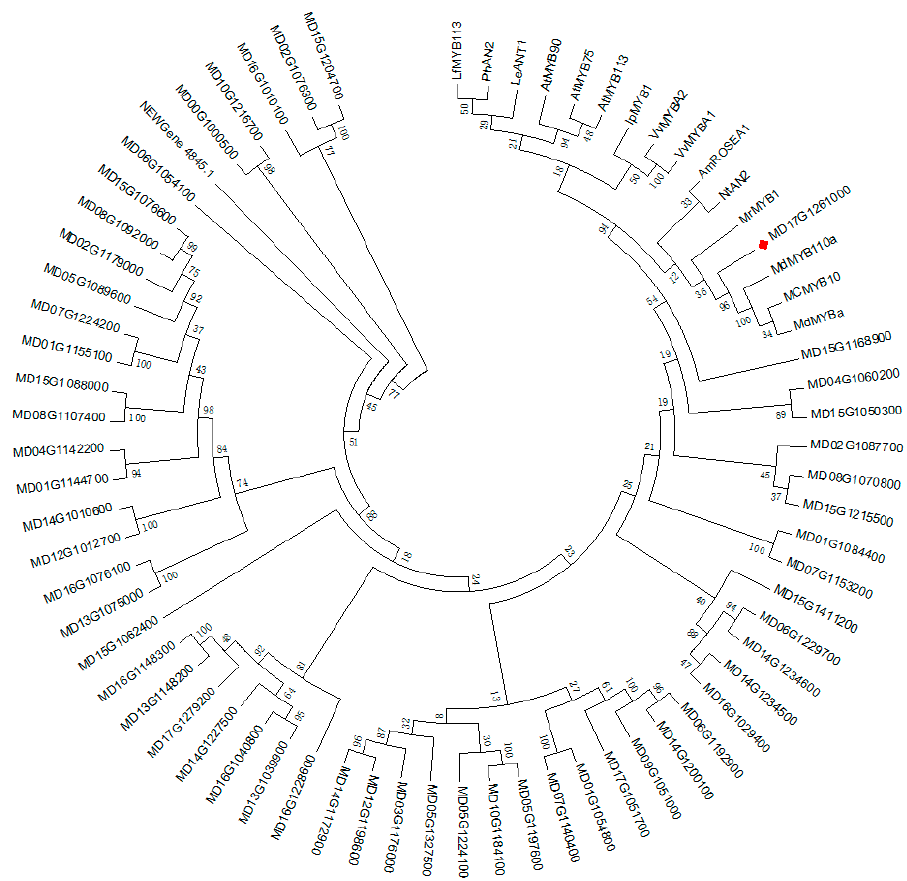
Figure 6. Phylogenetic analysis of the MYB genes involved in the regulation of anthocyanin biosynthesis in M . ‘Profusion’ and other plants. GenBank accession numbers for the MYB genes are as follows: LfMYB113 (ACO52472.1), PhAN2 (BAP28593.1), LeANT1 (AAQ55181.1), AtMYB90